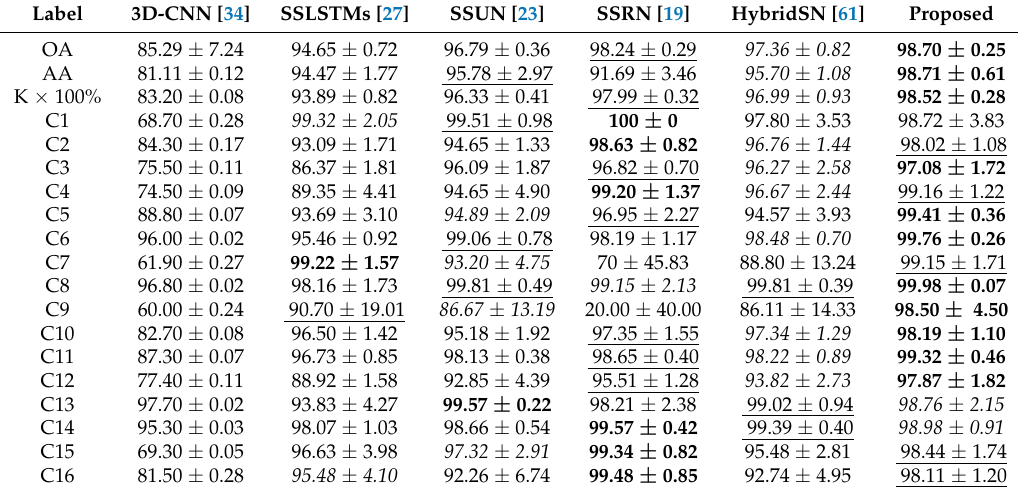
Table 6. Overall Accuracy, Average Accuracy, Kappa Value, and Class Wise Accuracy of our proposed method versus other methods on IP dataset when using 10% training samples. The best performance is in bold, the second-best performance is underlined, and the third-best is in italic.